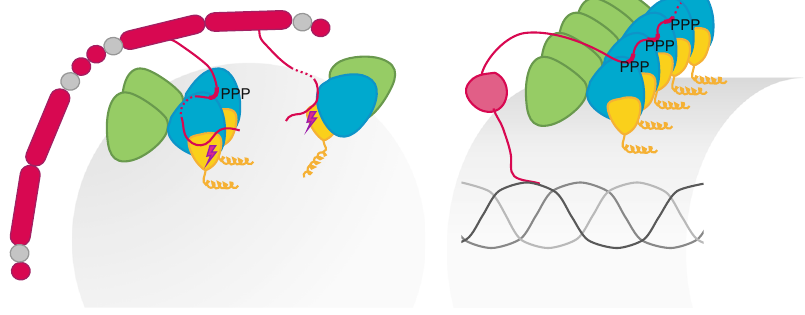
Fig. 5 Model for regulation of COPII carrier size. A model that summarizes the fi ndings in this paper. On the left: Sec31 (red) binds to Sec23 (blue) through its PPP regions inducing inner coat assembly at the same time it promotes GTP hydrolysis and coat disassembly by binding through its catalytic peptide. This leads to small inner coat patches that insert Sar1 amphipathic helices randomly and curve the membrane in all directions. On the right: TANGO1 (pink) promotes inner coat assembly through PPP binding, without inducing GTP hydrolysis, while at the same time binding to procollagen molecules in the ER lumen. This leads to extensive assembly of the inner coat, consistent Sar1 orientation and parallel insertion of its amphipathic helix, and membrane tubulation, which promotes procollagen between neighboring Sec23 molecules at the inner coat lattice co-crystal structures to our fi tted atomic model of Sec23, which interface (Fig. 4d). This density lies adjacent to the gelsolin revealed correspondence between the extra density and the PPP domain of Sec23, a region recently identi fi ed as a site of inter- binding site (Fig. 4d). Thus, our structure suggests that Sec31 action between human Sec23 and PPP-containing peptides of binds to Sec23 through PPP motifs at the same site as TANGO1, TANGO1 (ref. 9 ). We superimposed the hSec23-TANGO1-PPP consistent with biochemical experiments that showed